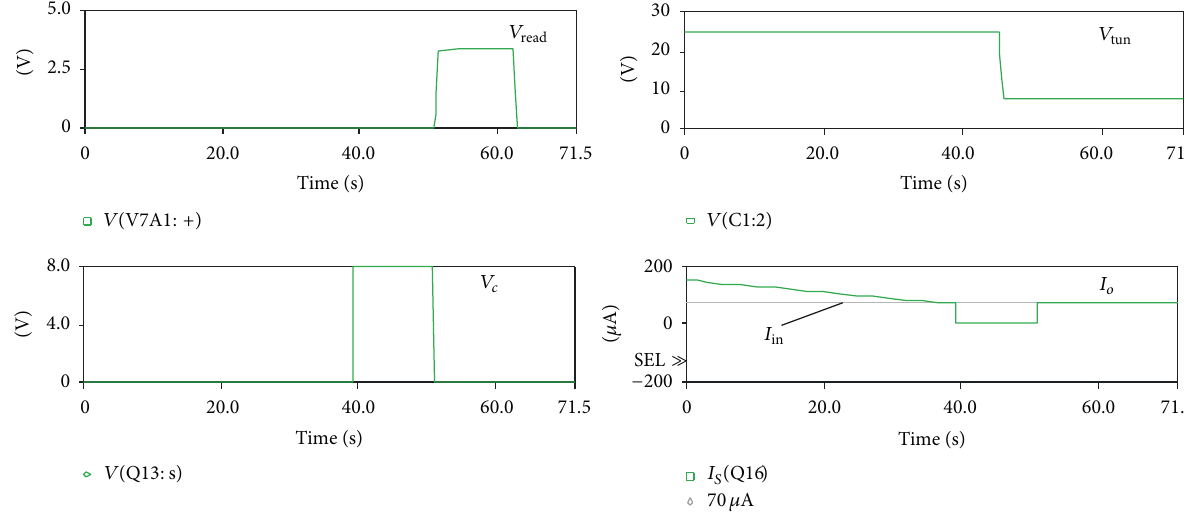
Figure 7: Transient simulation of the analog memory cell for a 70 𝜇 A input current.